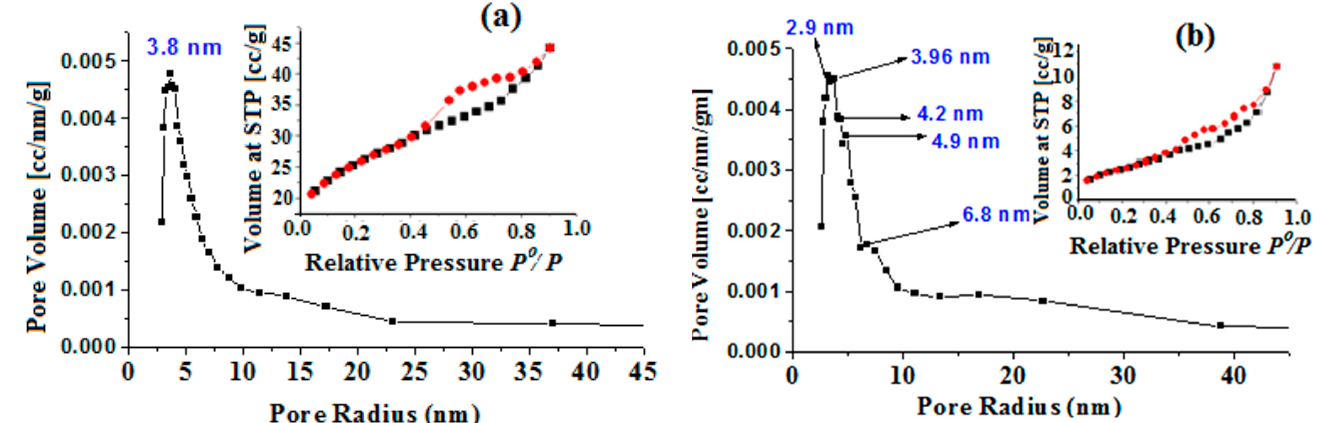
Figure 6. Isotherm and PSD curves of ( a ) [Ag 0.05 ZnO 0.05 V 2 O 5(0.90) ] and ( b ) [Ag 0.05 ZnO 0.05 V 2 O 5(0.90) ] N . Table 1. Textural analysis of the as-prepared photocatalysts.